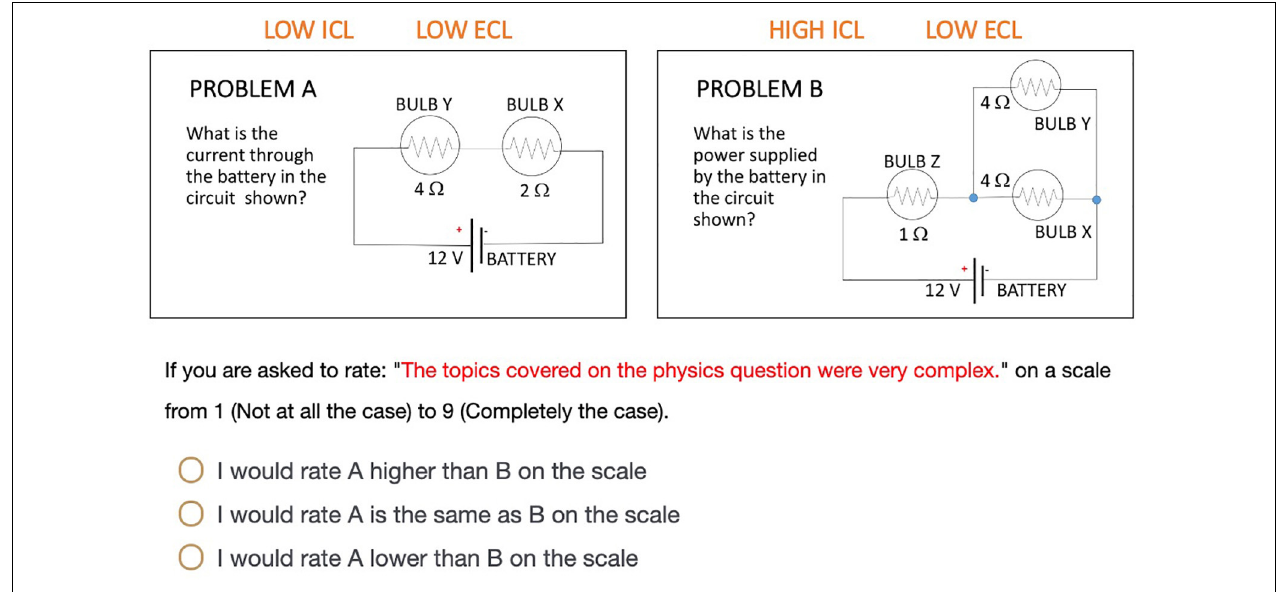
FIGURE 2 | Example of questions participants had to respond to during the cognitive load survey rating session.